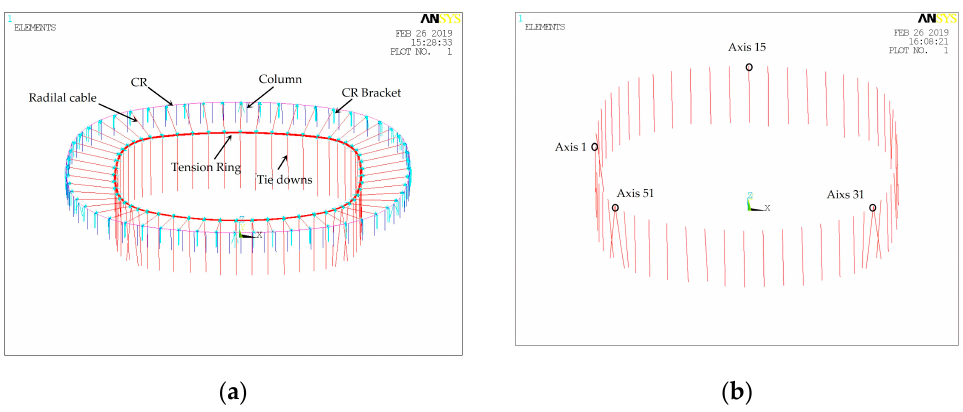
Figure 34. Tie-down tension analysis model. ( a ) Whole model; ( b ) Tie-downs. Table 14. Material characteristics of tie-downs.